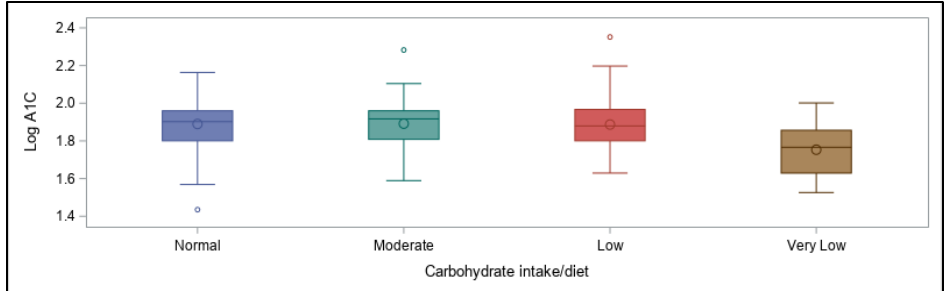
Figure 9. Usual daily carbohydrate intake and association with log A1C values.